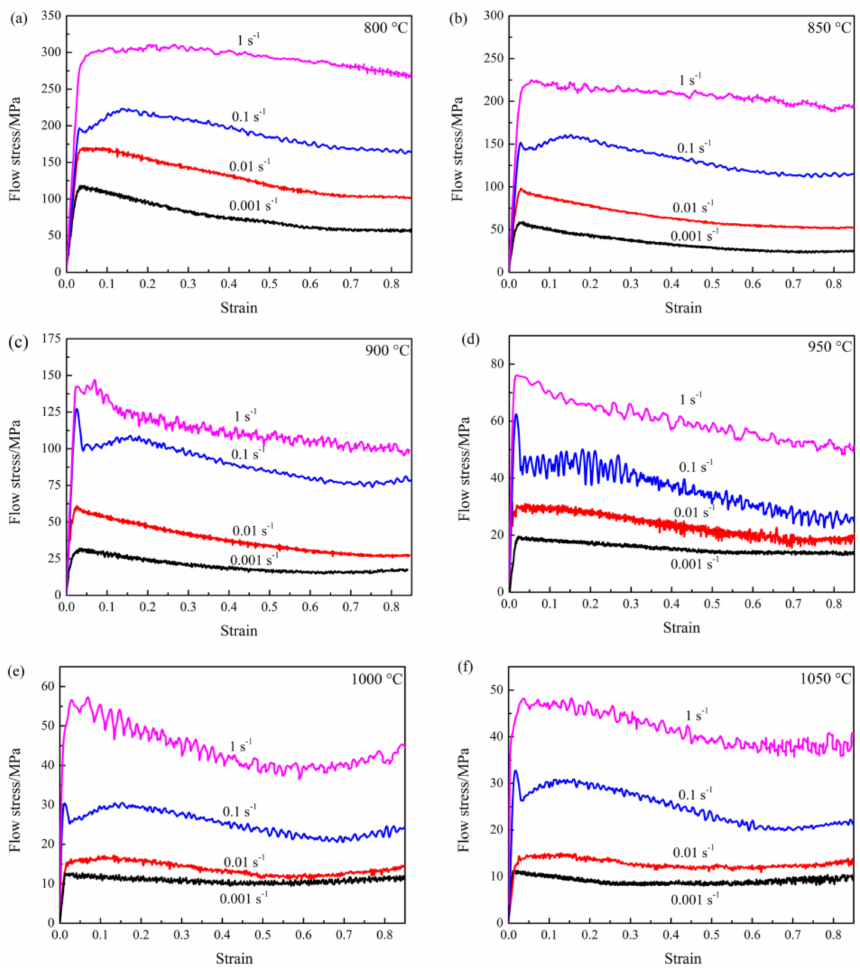
Figure 3. Friction and temperature corrected flow stress curves of isothermally compressed Ti-6Al-4V alloy at different deformation temperatures: ( a ) 800 ◦ C; ( b ) 850 ◦ C; ( c ) 900 ◦ C; ( d ) 950 ◦ C; ( e ) 1000 ◦ C; ( f ) 1050 ◦